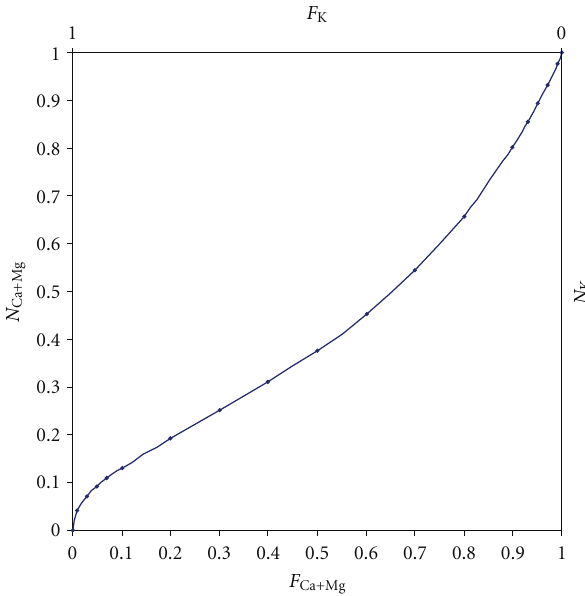
Figure 1: Normalized exchange isotherm following the Gapon equation for K – (Ca + Mg) exchange with K G = 16.58 (l/mole) 0 . 5 , corresponding to total electrolyte level of 0.01 normal. Ca exchange is slightly unfavorable when potassium is present except for very low